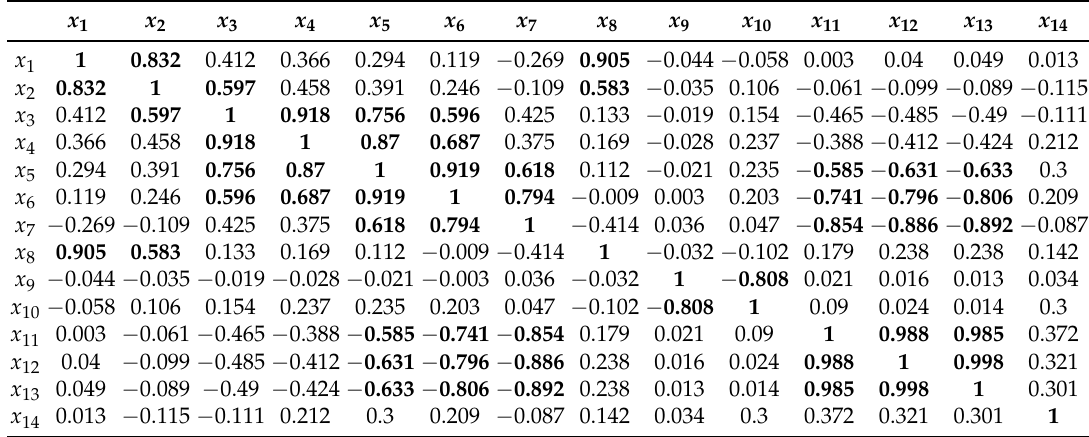
Table 3. Pairwise Correlation Matrix for the Selected Input Variables.